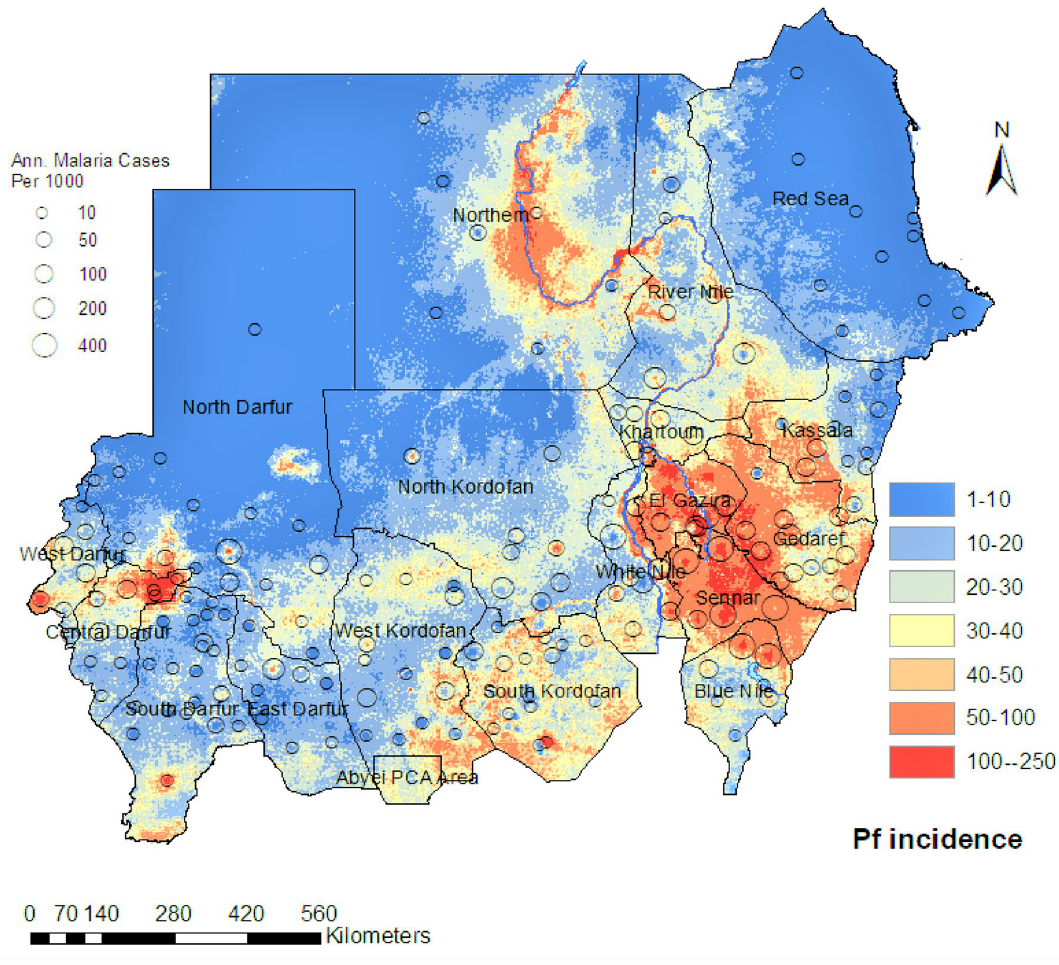
Figure 2. A fine-scale map ( 1 × 1 km) of the estimated annual incidence of clinical Plasmodium falciparum malaria per 1000 in Sudan for years 2017–2019. Hollow circles represent reported cases per year within each locality. Colour shading represents predicted values derived from a Bayesian geostatistical